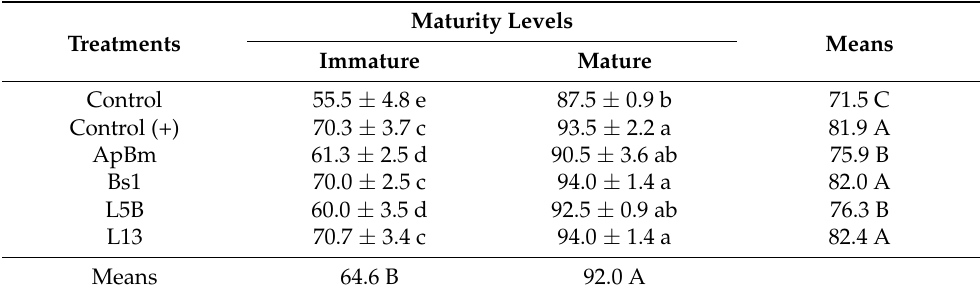
Table 1. Effect of endophytic bacteria inoculation on mean germination percentages of immature and mature pepper seeds.